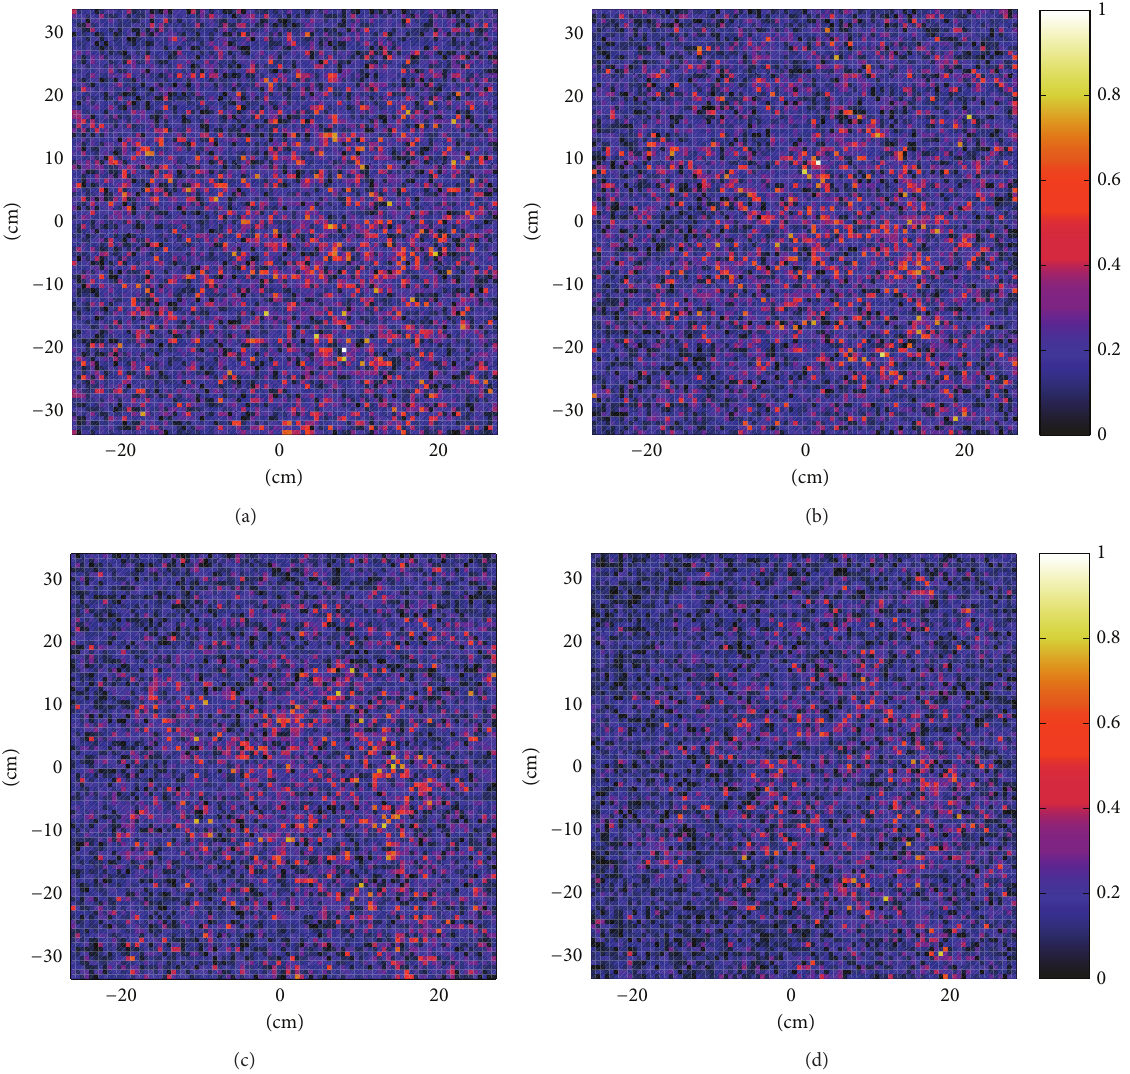
Figure 5: Reconstructed images of the person under test using a traditional SAR algorithm at four different ranges: (a) 𝑥 0 + 0 mm, (b) + 30 mm, (c) 𝑥 + 60 mm, and (d) 𝑥 + 90 𝑥 0 0 0